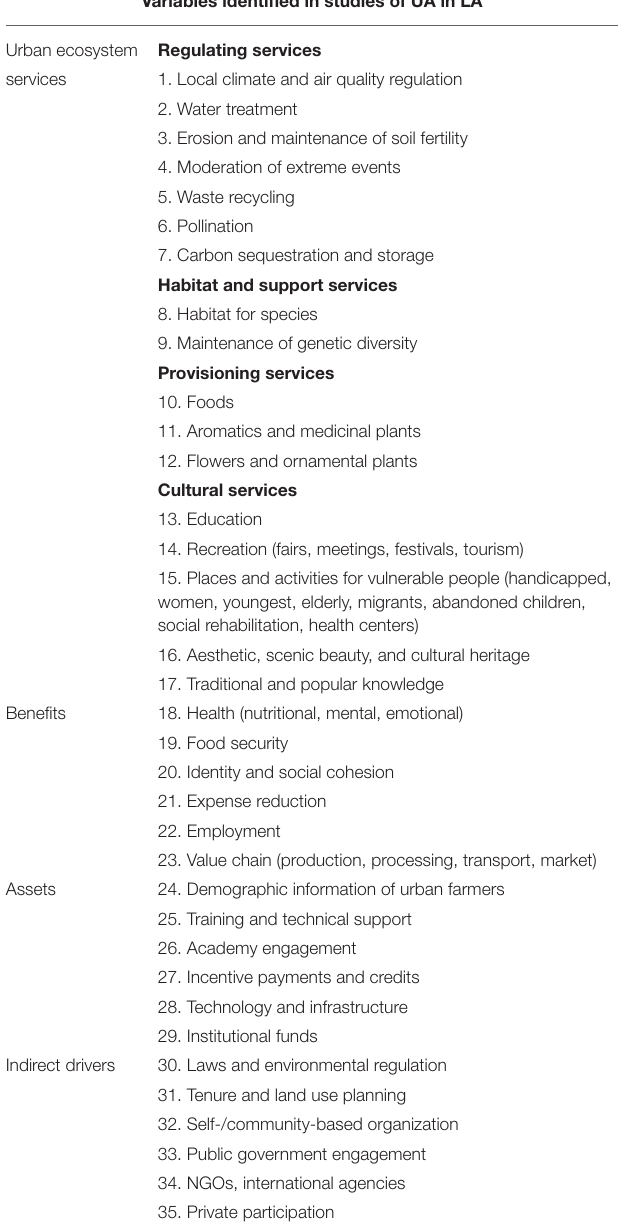
TABLE 1 | Urban ecosystem services, benefits, assets, and drivers identified in studies of UA in LA. Variables identified in studies of UA in